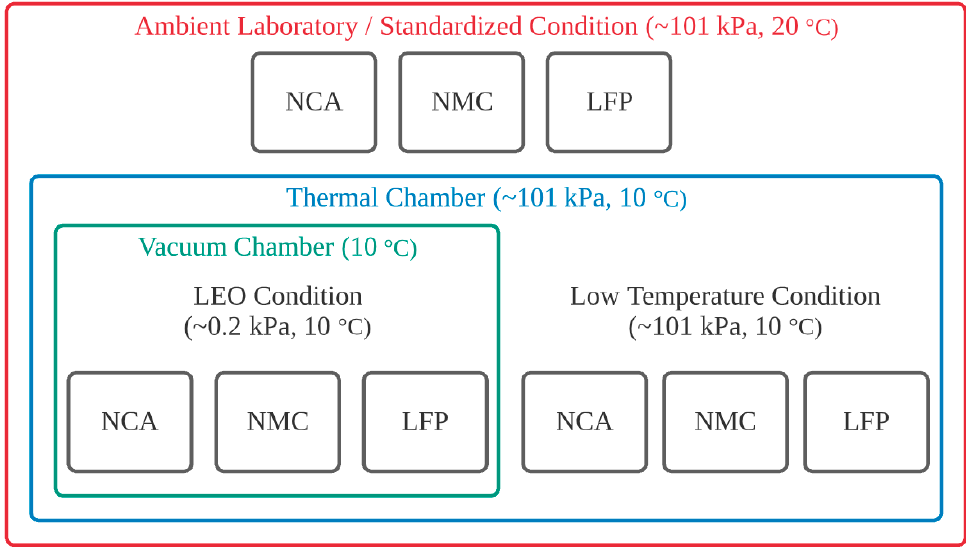
Figure 1. Experimental test configuration showing the temperature and pressure values for each of the three test condi- tions.